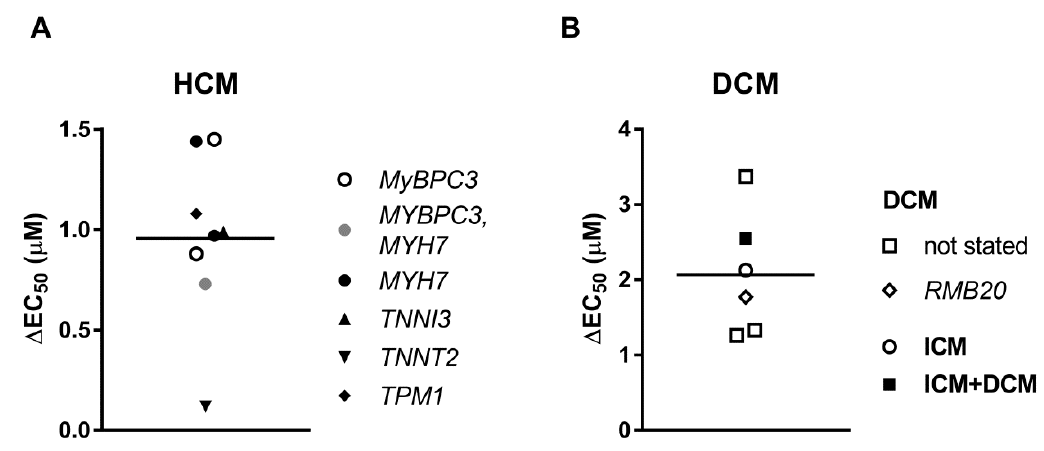
Figure 4. An increase in EC 50 after phosphorylation with protein kinase A (PKA) for HCM ( A ) and DCM ( B ) muscle samples. Each data point represents a different experimental group where the symbols indicate genes where mutations were found. See also Tables 1 and 2.